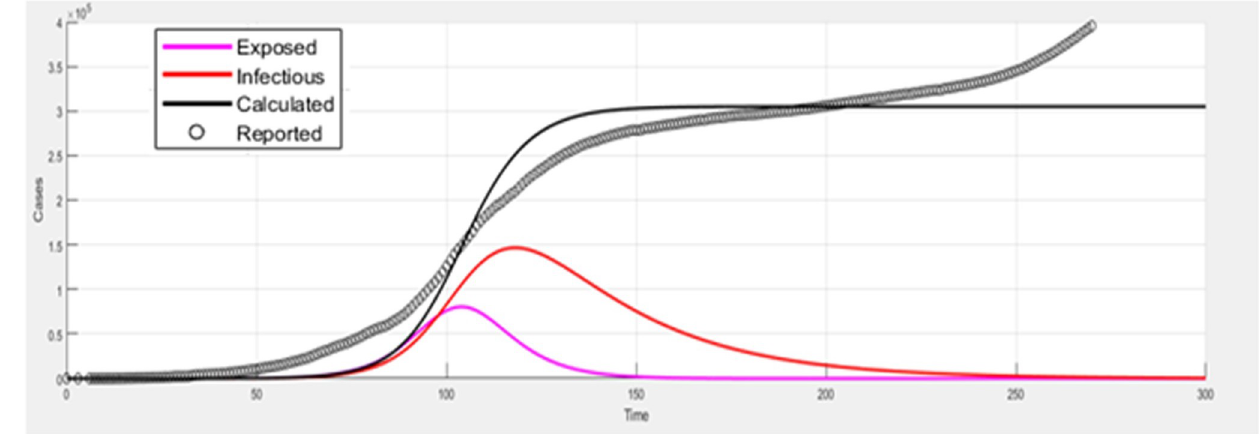
Fig 3. Proposed hybrid model with prediction.